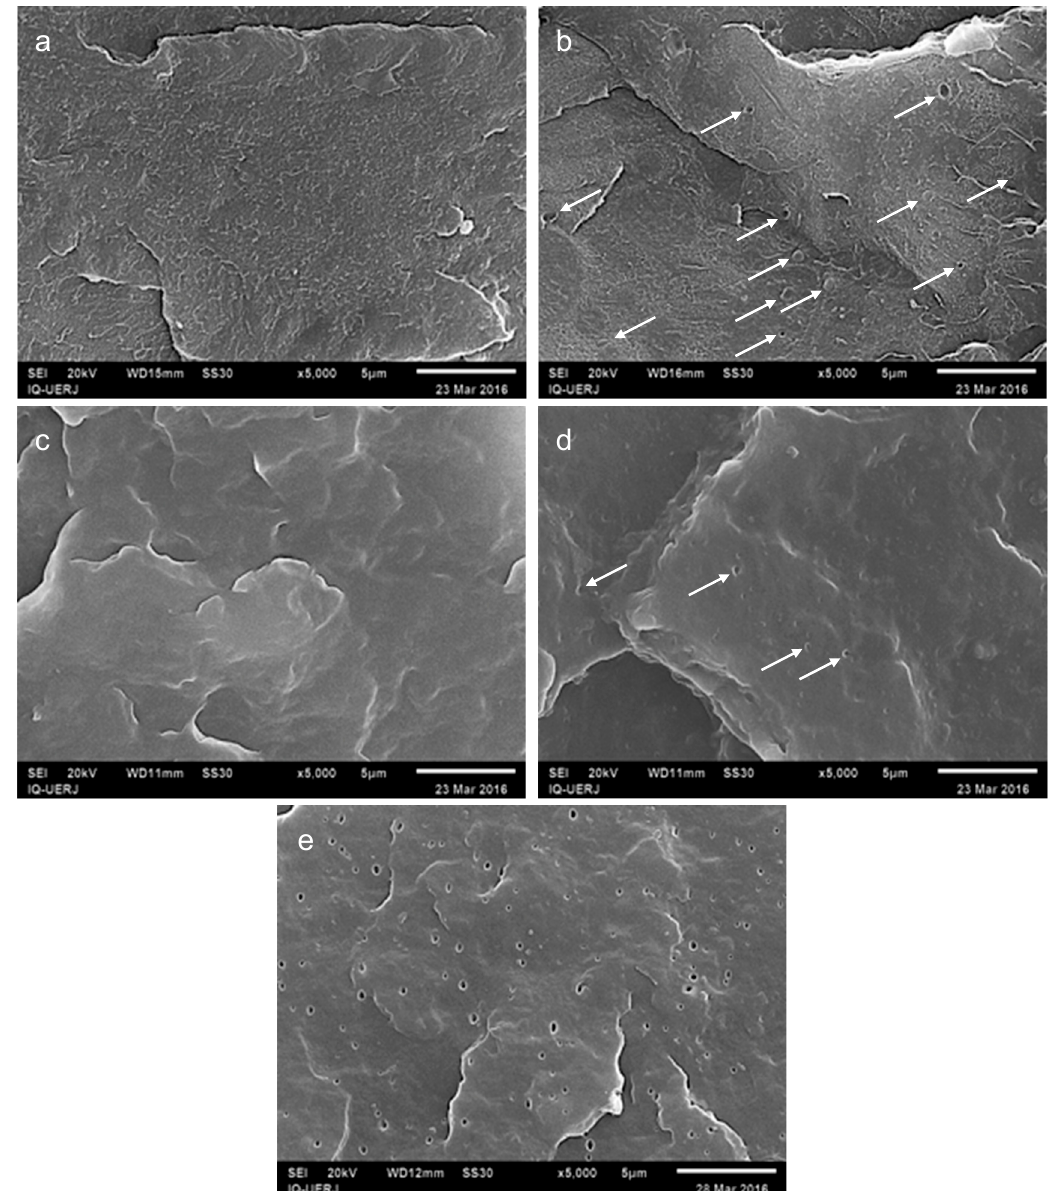
Figure 2. SEM micrographs of neat resins: ( a ) HIPS (without CNSL); ( b ) HIPS with 5 phr CNSL; ( c ) PP (without CNSL); ( d ) PP with 5 phr CNSL; (e) PP with 5 phr of CNSL, after chloroform extraction; 5000× amplification (5 μ m scale).